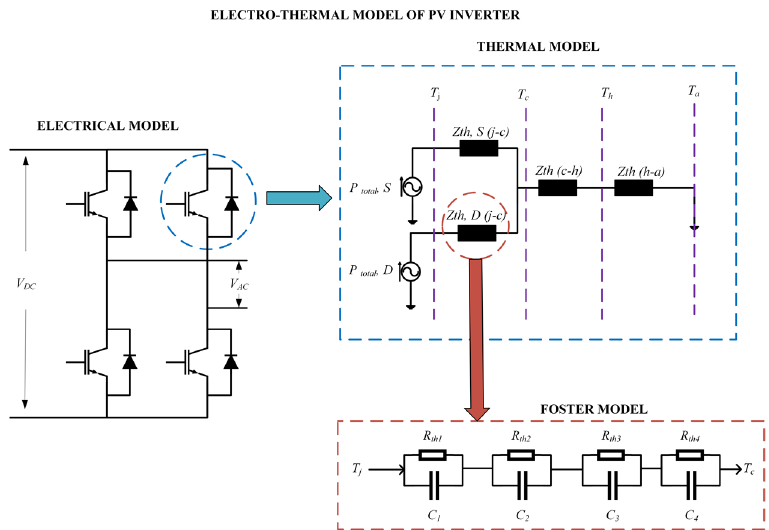
Figure 3. FETM of a PV inverter.